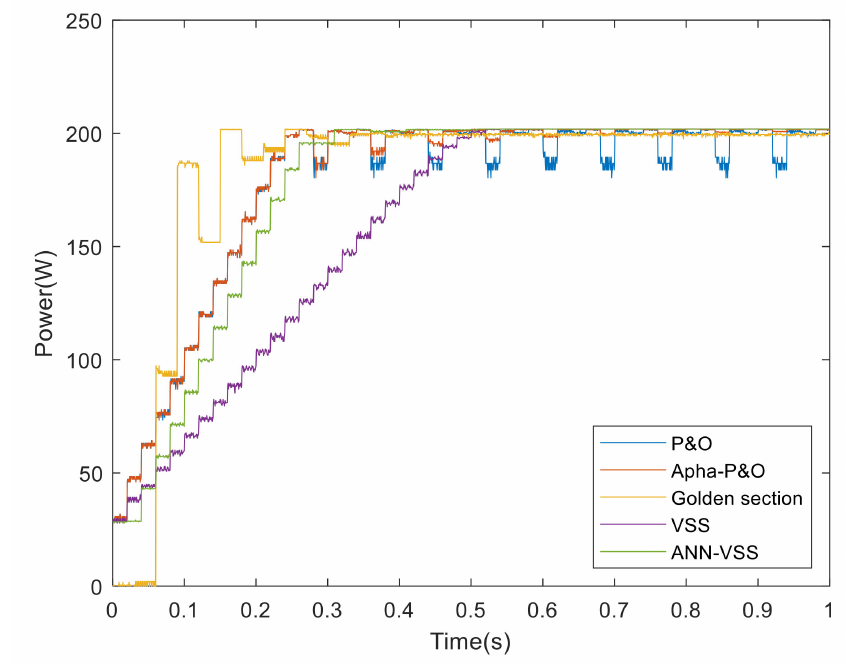
Figure 12. Experimental tracking waveforms of five compared MPPT methods (500 W/m 2 ).